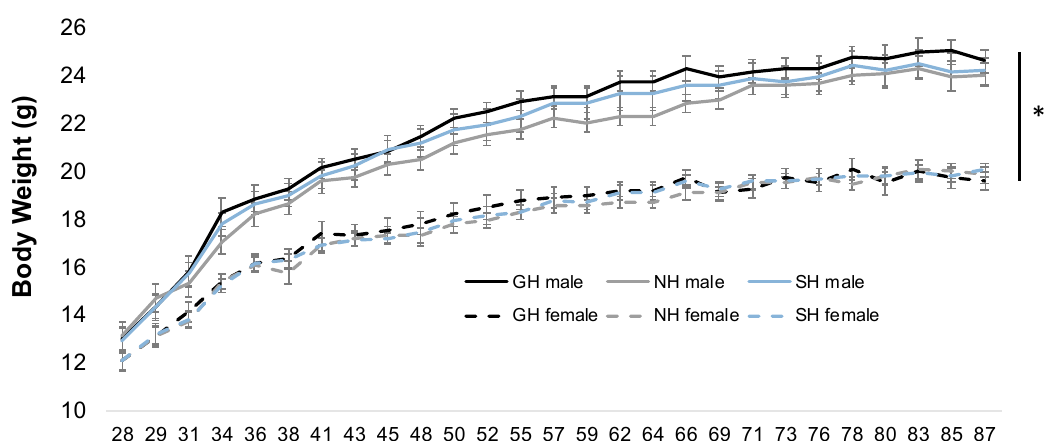
Figure 2. Housing condition does not alter bodyweight. While bodyweights significantly increased over time, housing condition did not alter this trajectory. Males weighed significantly more than females, * p < 0.001, main effect of sex by two-way RMANOVA.